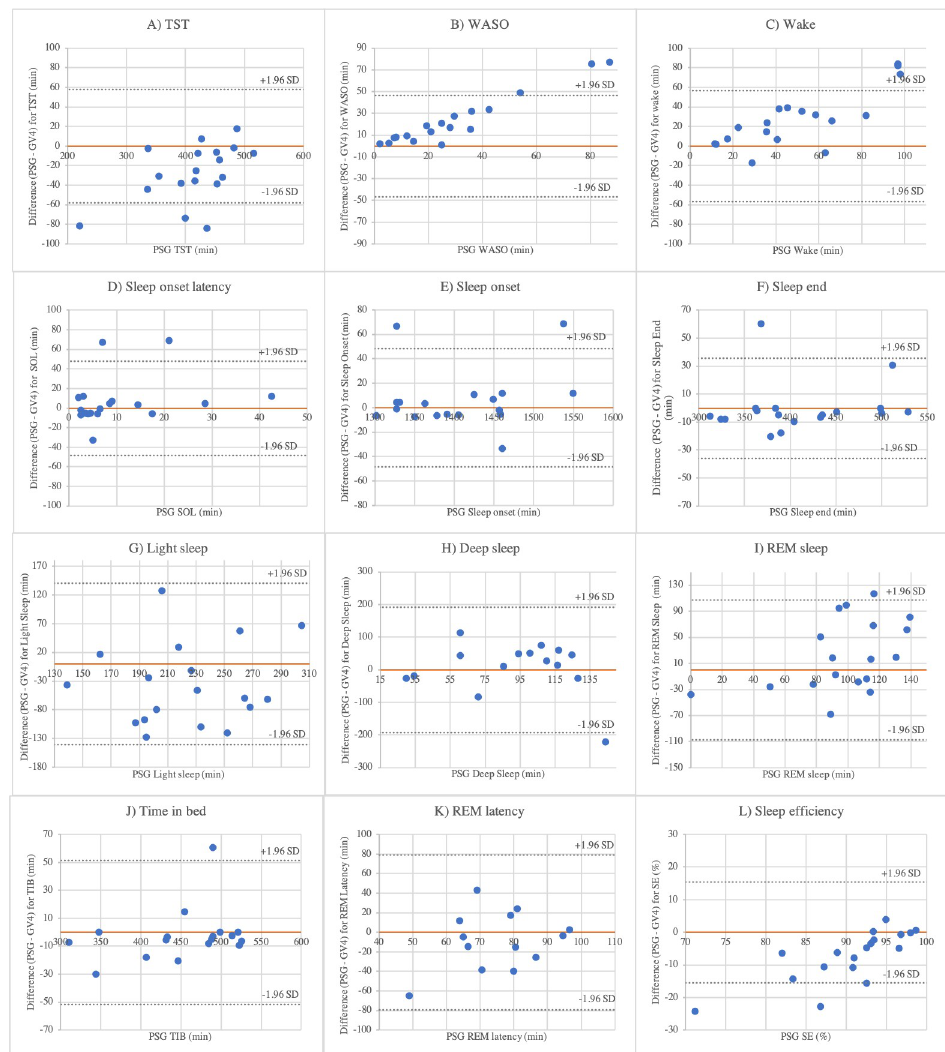
Fig 1. Bland-Altman plots for agreement between PSG and GV4 measured TST (A) and WASO (B). 3.4.3 Linear regression analysis. Fig 2 illustrates the relationships between PSG and GV4 measured sleep onset and sleep end. The coefficients of determination, R 2 , indicate linearity in both cases. 3.4.4 Epoch-by-epoch analysis. Based on the confusion matrices, sensitivity was calcu-